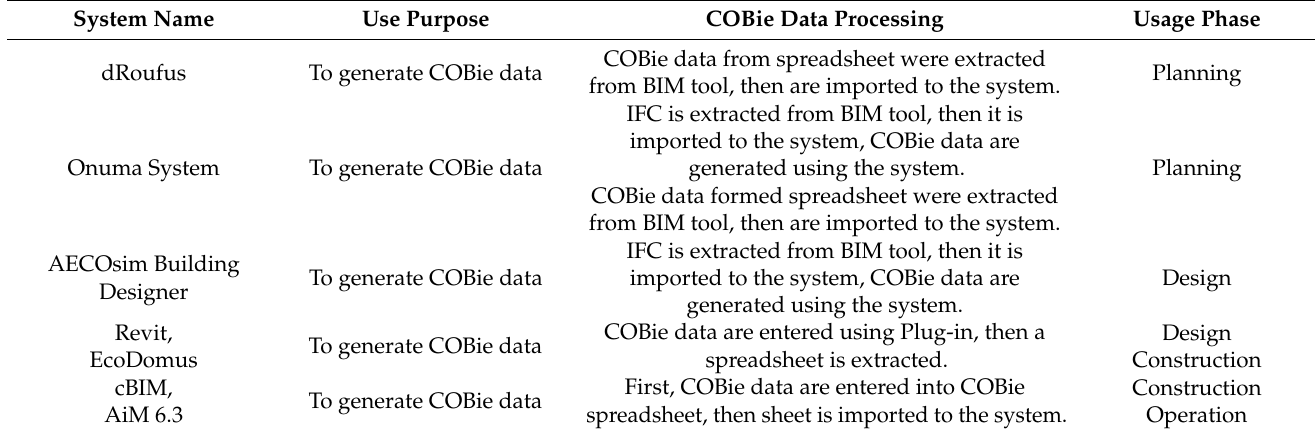
Table 2. Existing COBie